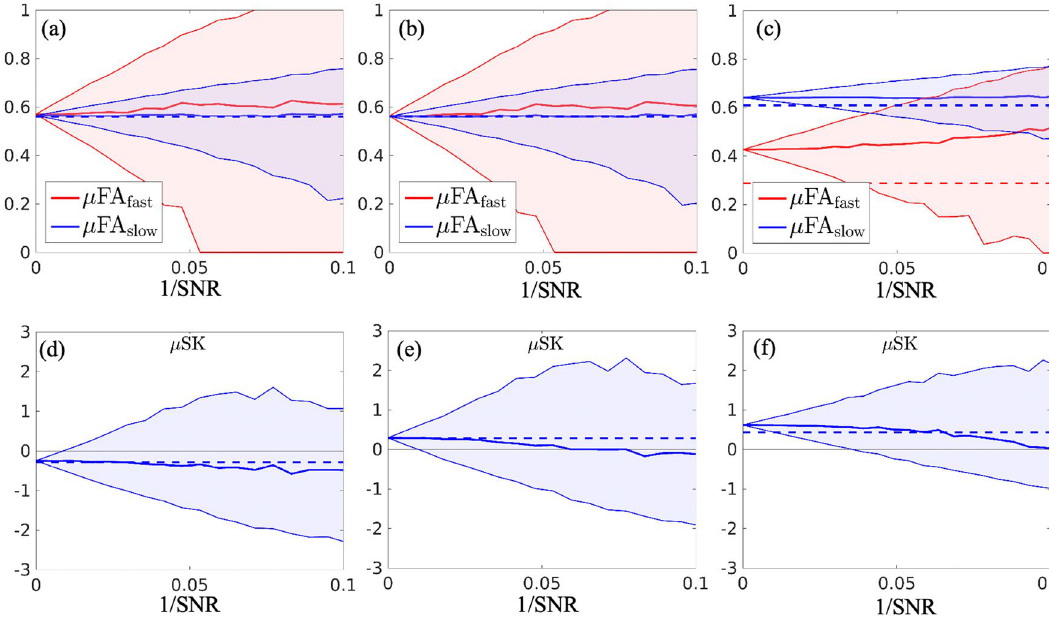
Figure 4. Illustration of estimated dMRI indices of the three synthetic DTDs in Fig. 1 using the diffusion encoding sequences shown in Fig. 2 with different levels of measurement noise. The horizontal axis of these plots illustrates the inverse signal-to-noise ratio (1/SNR). The upper and lower boundary of the red and blue shaded areas in ( a )–( c ) illustrate the 25% and 75% percentiles of the 5000 sampled values of µ FA fast and µ FA slow of the three synthetic structures, respectively. The red and blue solid lines show the median values of the sampled of µ FA fast and µ FA slow values with the underlying true values indicated by the dashed lines. Similarly, the shaded plots in ( d )–( f ) illustrate the 25% and 75% percentiles of the sampled µ SK values with the median and true values shown by the solid and dashed lines.